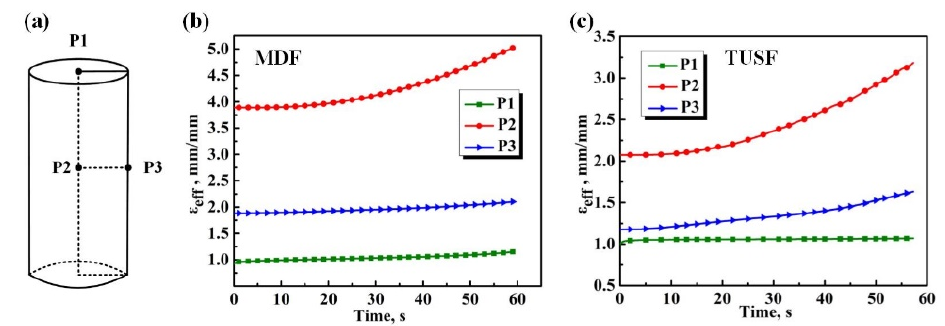
Figure 16. Time-dependent effective strain curves for ( b ) MDF and ( c ) TUSF specimens at ( a ) different tracking points.